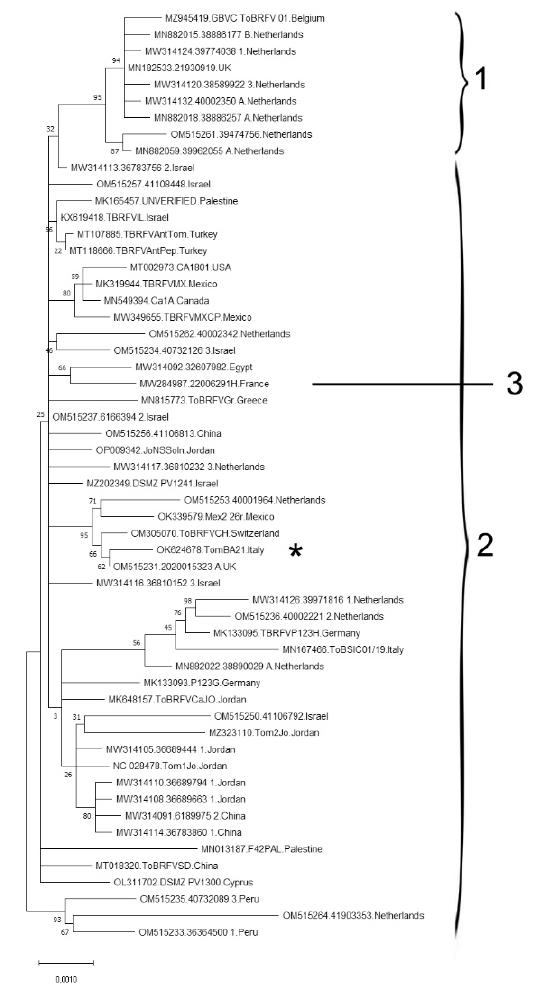
Figure 4. Maximum-likelihood phylogenetic tree by using the method with HKY+G model and 1000 replicates bootstrap value. The distribution of 56 ToBRFV isolates, based on their complete genome sequences, is shown. The asterisk marks the position in the tree of the Italian isolate ToBRFV- Tom-BA21 under study. The sequence of a different tobamovirus species, ToMMV-MX5 (GenBank acc. no. NC_022230), was used as the outgroup to root the tree MEGA X software (not shown in the figure). Numbering on the right side of the graph refers to the three ToBRFV phylogenetic groups as described by Çelik and coauthors [28].